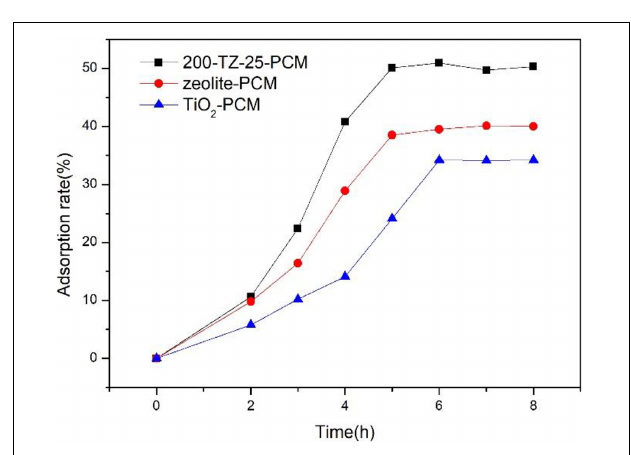
FIGURE 5 | TCAcAm adsorption rate of TiO 2 , Zeolite, and